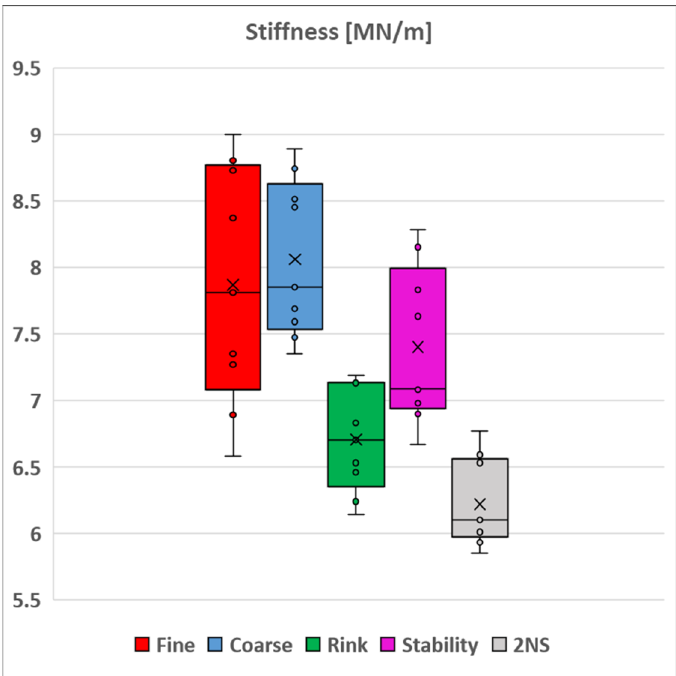
Figure 6. Box plot of the soil stiffness values [MN/m] for each of the individual soil types from all laboratory trials.